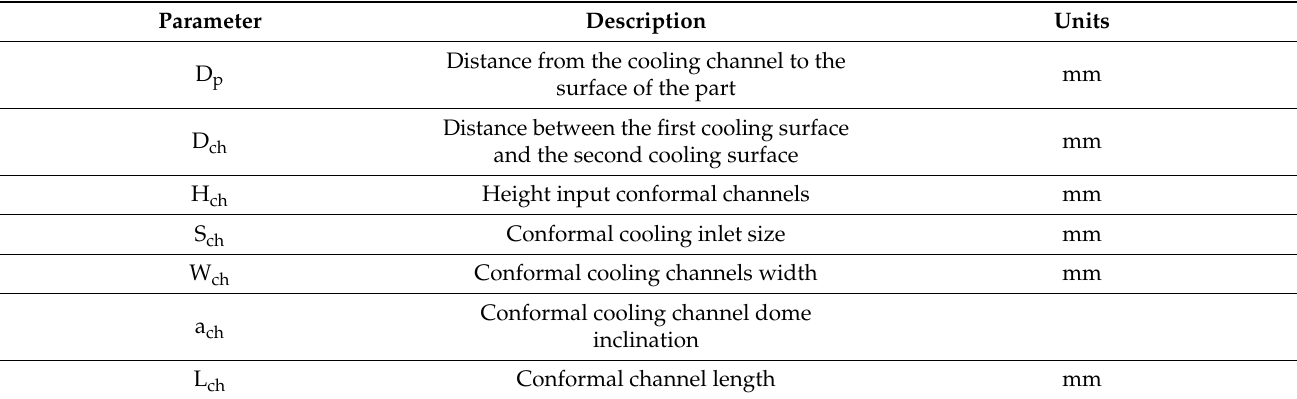
Table 1. Parameters of the new conformal cooling design for collimators.